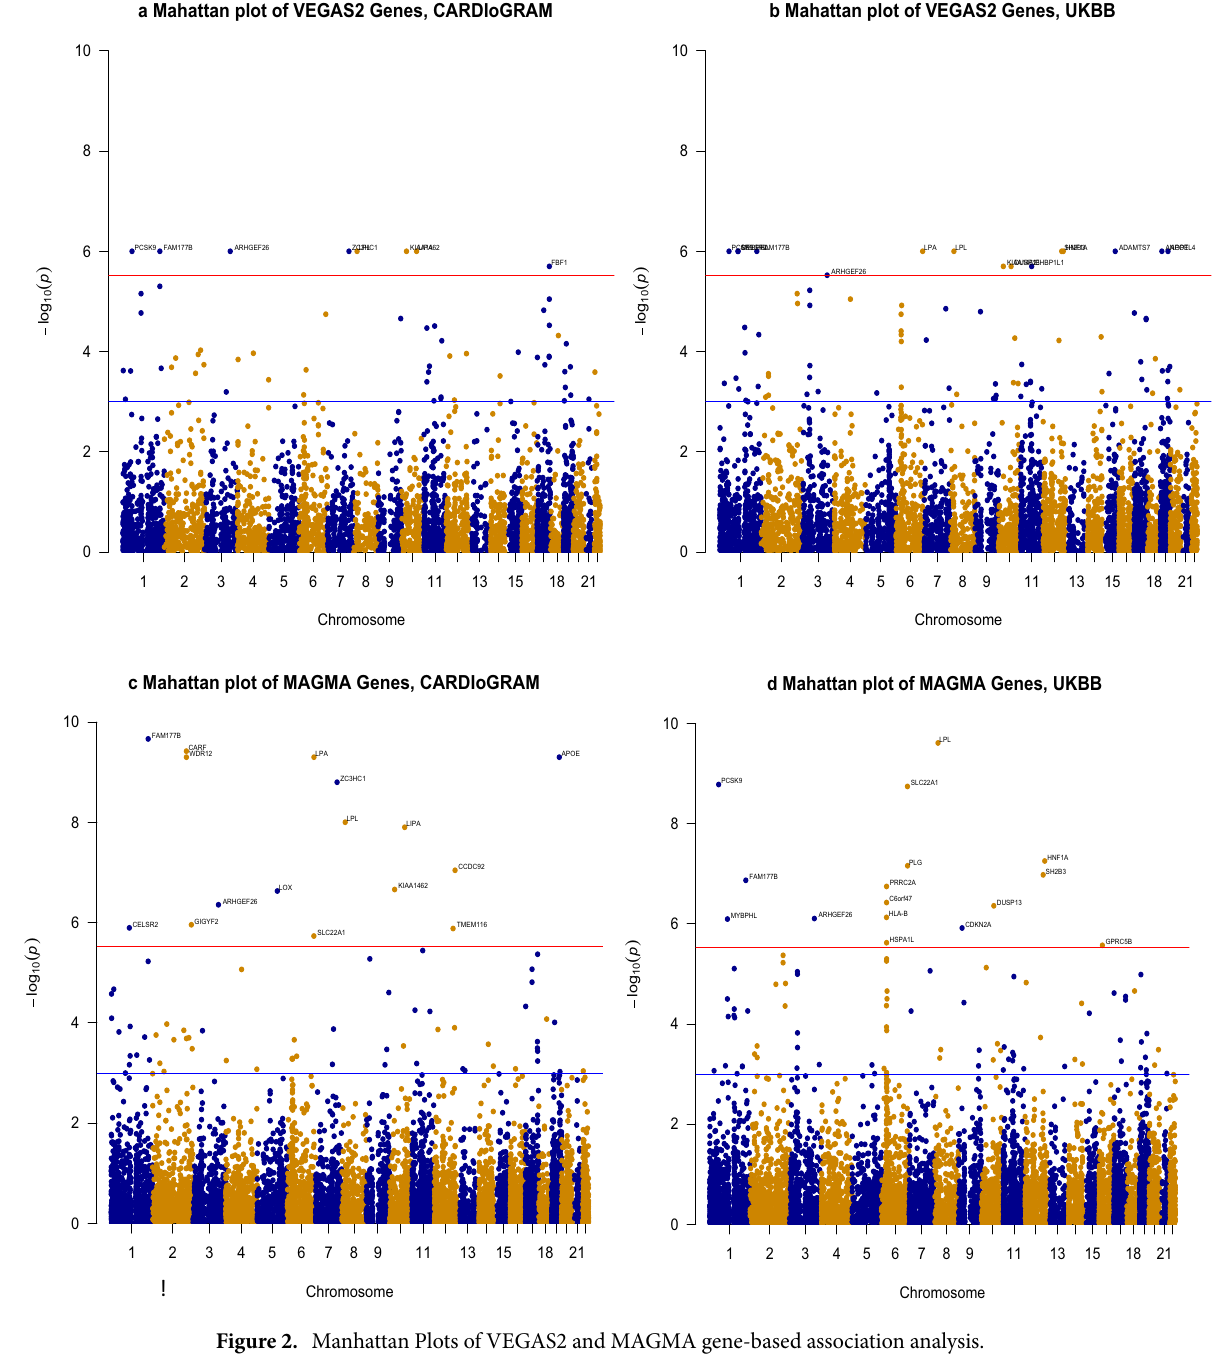
Figure 2. Manhattan Plots of VEGAS2 and MAGMA gene-based association